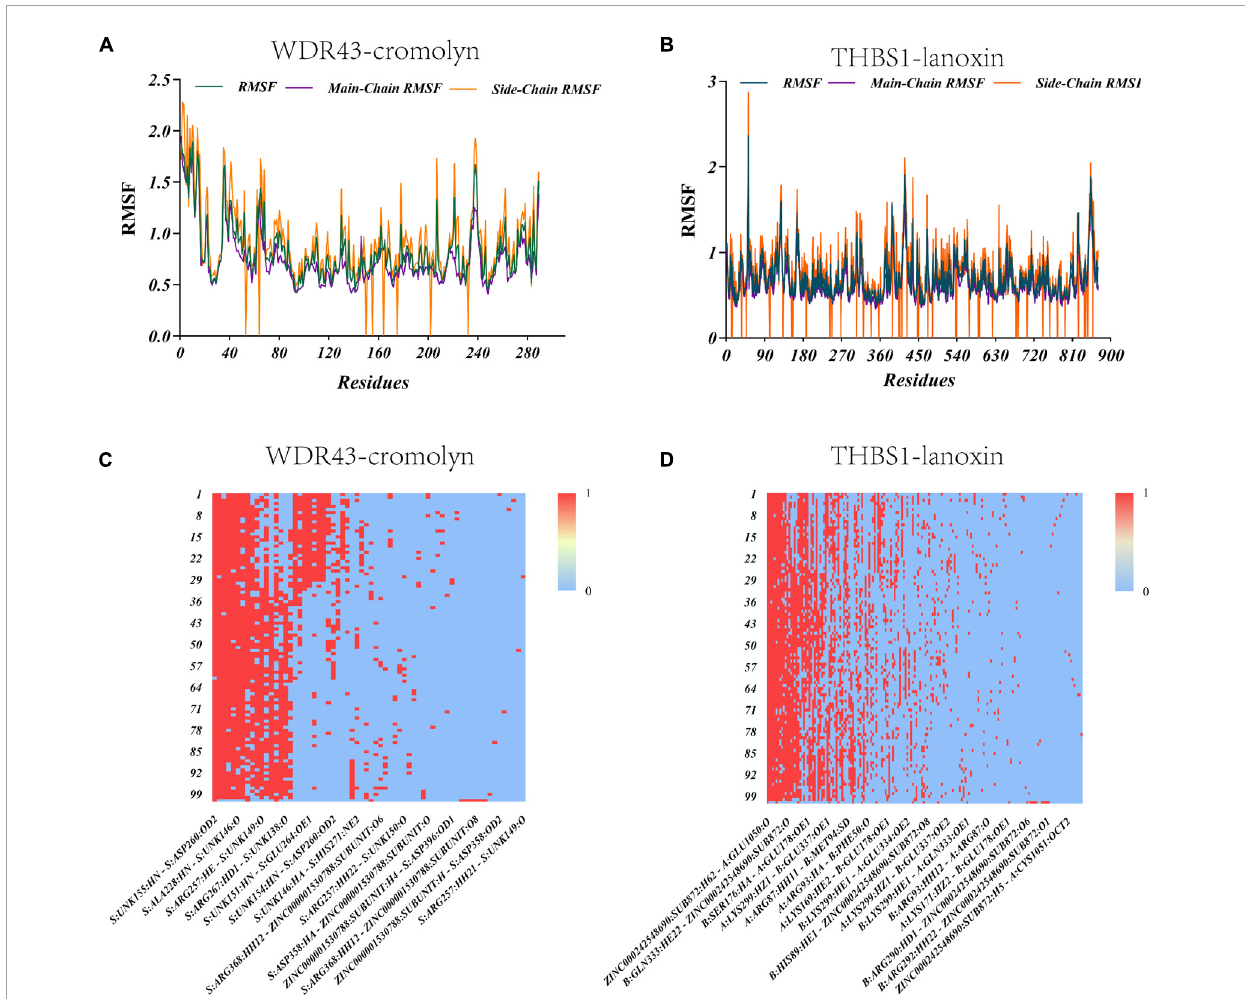
FIGURE5 Thermograms demonstrating the root-mean-square fluctuation (RMSF) values and hydrogen bond counts of the two systems. (A) Changes in RMSF values of the WDR43-cromolyn complex. (B) Changes in RMSF values of the THBS1–lanoxin complex. (C) Thermogram demonstrating the hydrogen bonds in the WDR43-cromolyn complex. (D) Thermogram demonstrating the hydrogen bonds in the THBS1-lanoxin